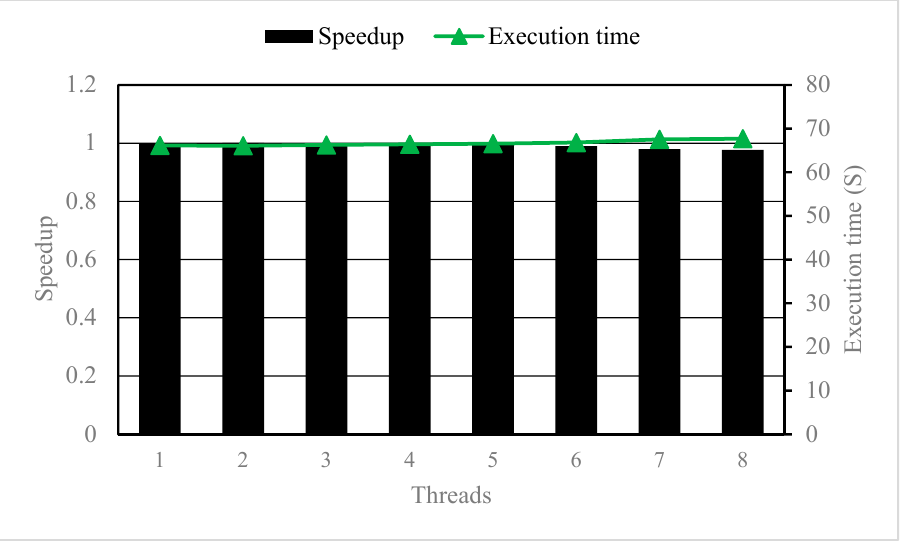
Figure 8. The Speedup and execution time with different number of threads when parallelizing the K loop.